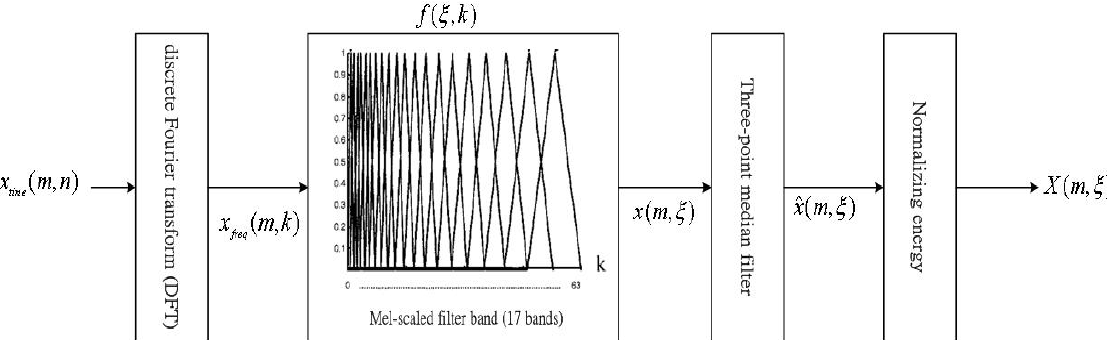
Figure 6. The processing of the Mel-scale filter